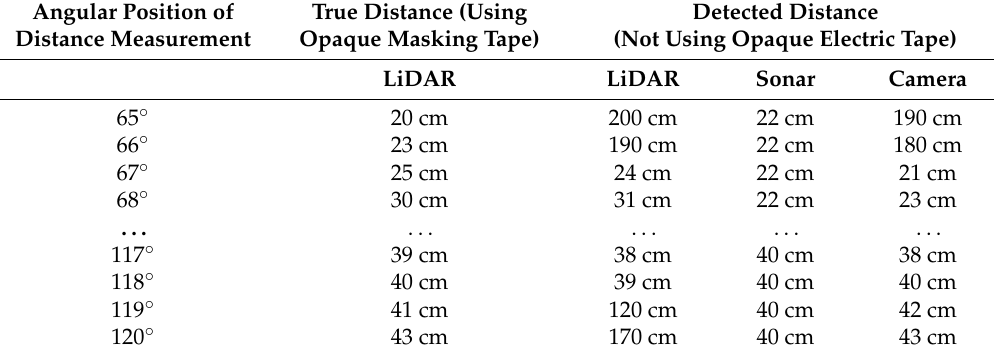
Table 3. ANN training dataset